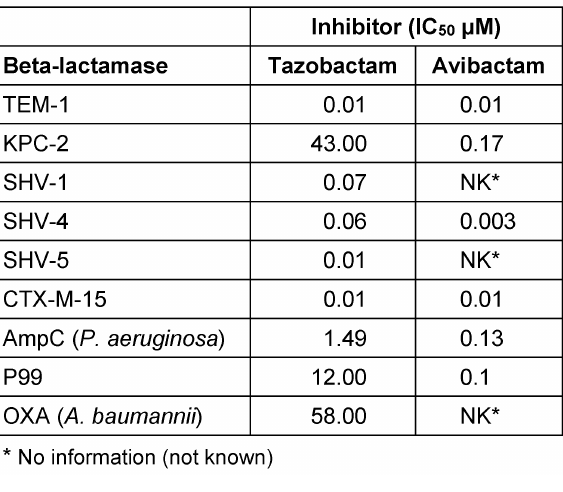
Table 1: Activity of beta-lactamase inhibitors